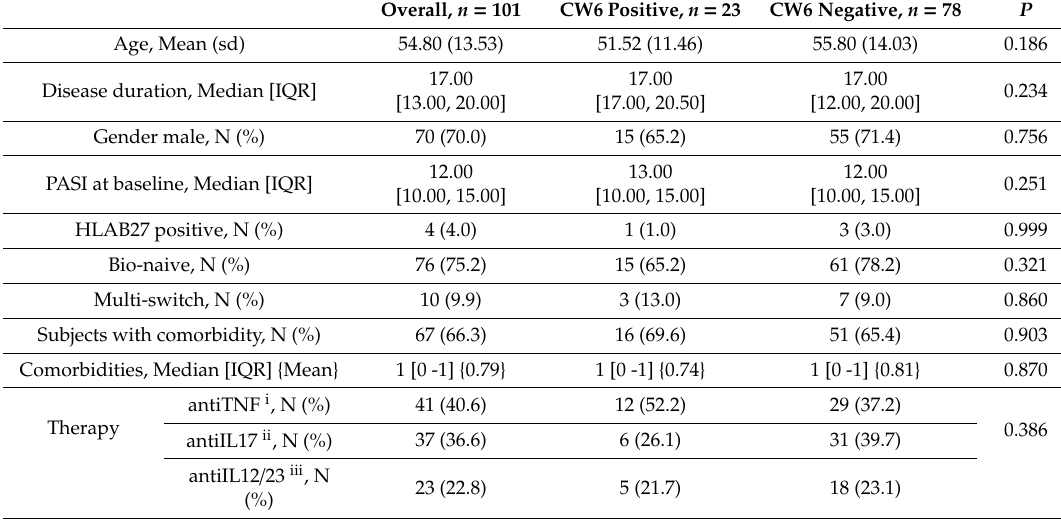
Table 1. Baseline